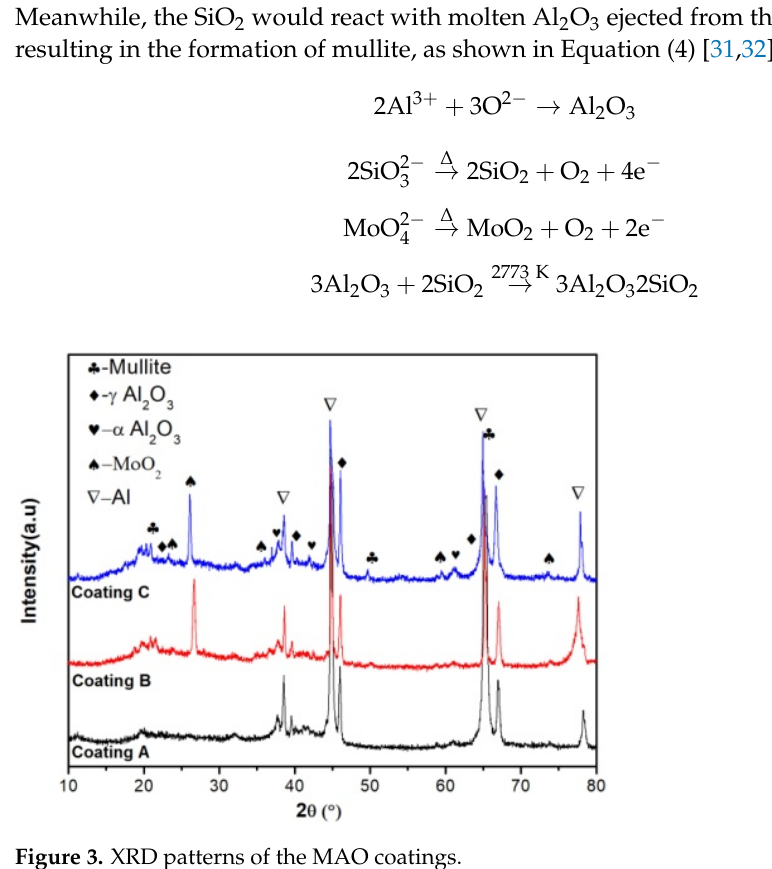
Figure 2. ( a ) Cross-section morphology of coating C, and ( b ) distribution of elements of coating C.